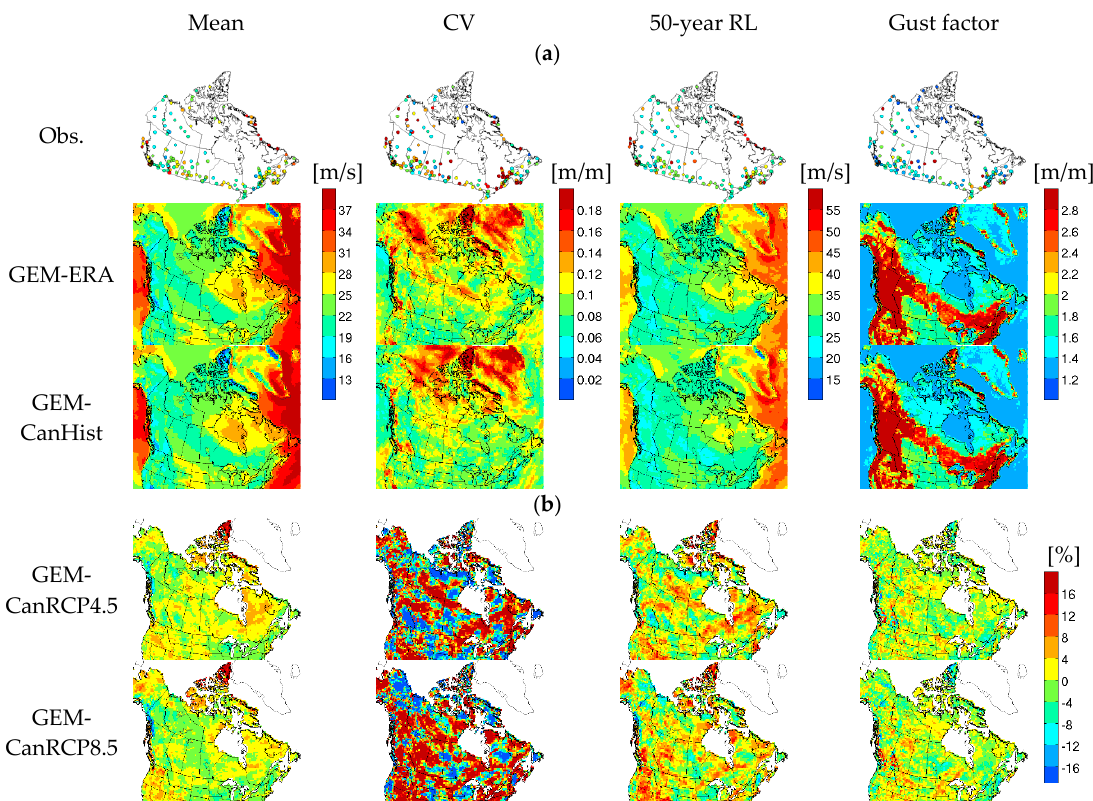
Figure 10. ( a ) Mean, coefficient of variation (CV), and 50-year RL of annual maximum wind gust, as well as gust factor (the ratio of 50-year RL of annual maximum wind gust to that of annual maximum wind speed), for observations and two GEM model simulations (i.e., GEM-ERA and GEM-CanHist), for the 1981–2010 period. ( b ) Projected changes to the same characteristics as shown in ( a ) for the future 2071–2100 period with respect to the current 1981–2010 period.